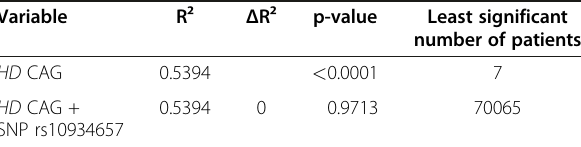
Table 3 Effect of SNP rs10934657 on AAO in HD (Analysis of covariance)